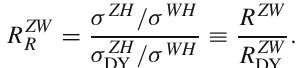
Fig. 2 a The p T spectrum of the Higgs boson produced through the gg - and b ¯ b -processes for different values of the top- and bottom-quark Yukawa couplings. b The ratio of the full ZH cross section to the DY component. The latter was obtained at NNLO with the help of MCFM [15], the new-physics effects in gg → ZH were calculated at